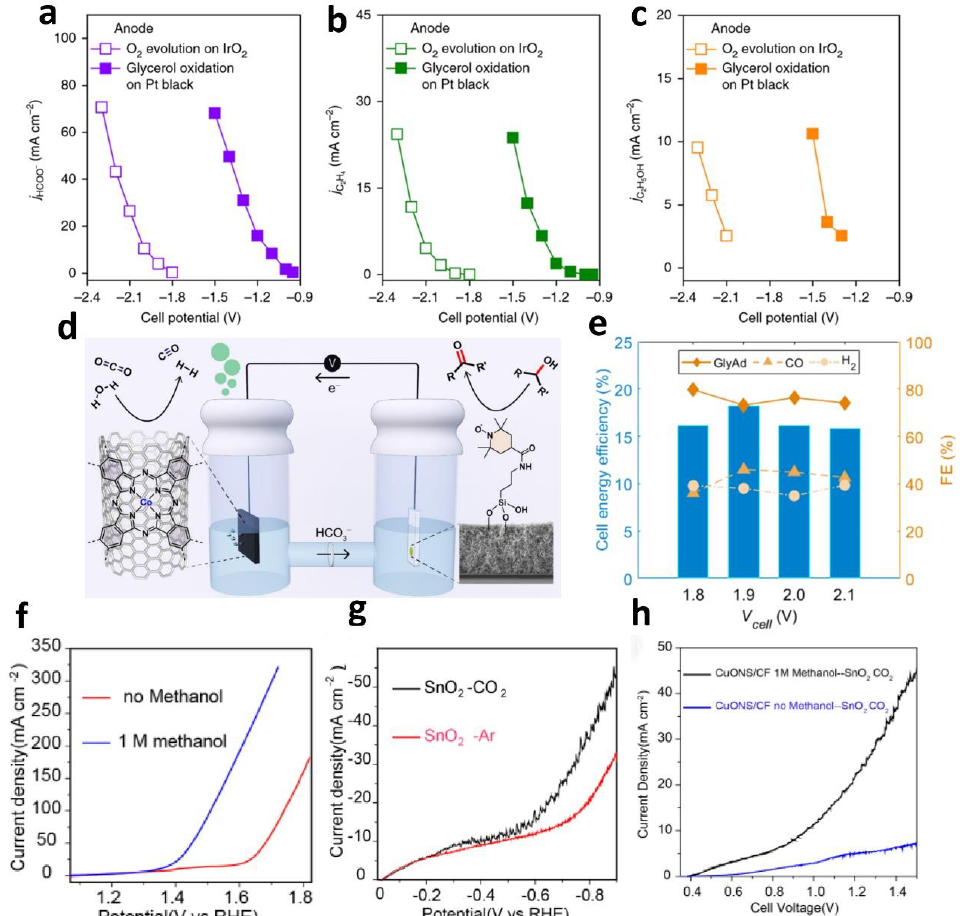
Figure 7. Electrocatalytic performances towards the CO 2 RR to HCOO − on tin ( a ) and to C 2 H 4 ( b ) and C 2 H 5 OH ( c ) on copper, coupled with oxygen evolution or glycerol electrooxidation at the anode, as a function of the applied cell potential for CO 2 RR on 1 ± 0.1 mg cm −2 tin or copper nanoparticle−coated gas diffusion layer cathodes. Reproduced with permission [29], Copyright 2019, Nature Publishing Group. ( d ) Scheme of hybrid electrolyzer of the OUR integrating with the CO 2 RR and ( e ) two−electrode cell energy efficiency and FE plotted as a function of the cell potential (V cell ). Reproduced with permission [98], Copyright 2020, Wiley Publishing Group. ( f ) LSV Polarization curves of CuONS/CF in 1.0 M KOH with and without methanol at 5 mV s −1 and ( g ) LSV Polarization curves of mSnO 2 /CC in 1.0 M KHCO 3 solutions. ( h ) Cathodic chamber: KHCO 3 solution saturated with CO 2. Anodic chamber: 1.0 M KOH with and without 1.0 M methanol; reproduced with permission [99], Copyright 2020, Nature Publishing